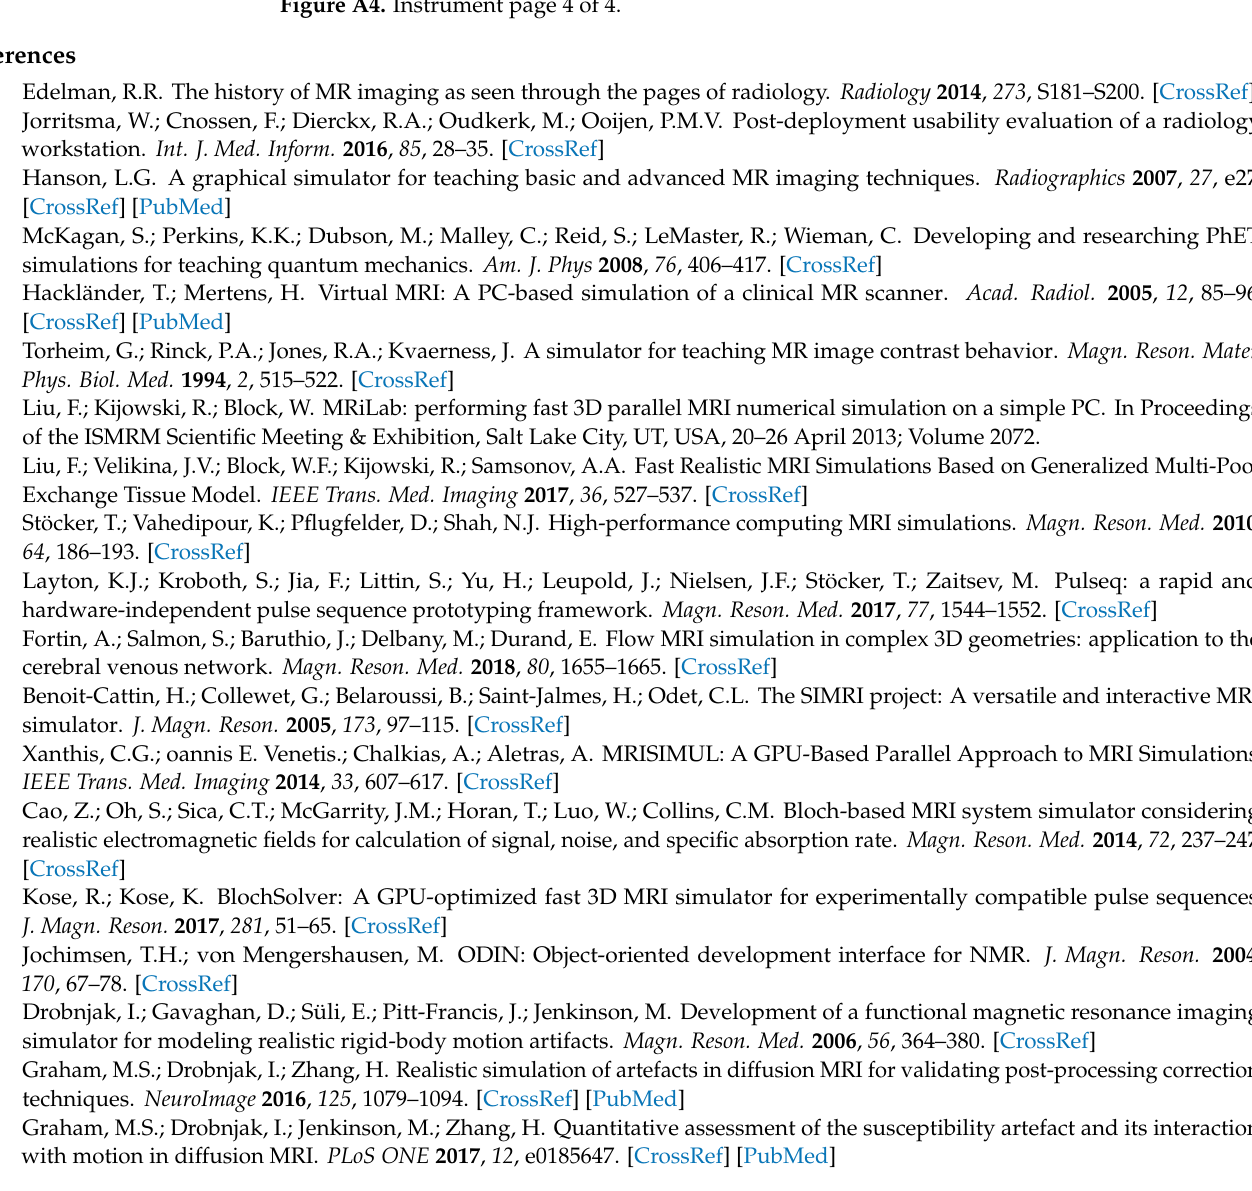
Figure A4. Instrument page 4 of